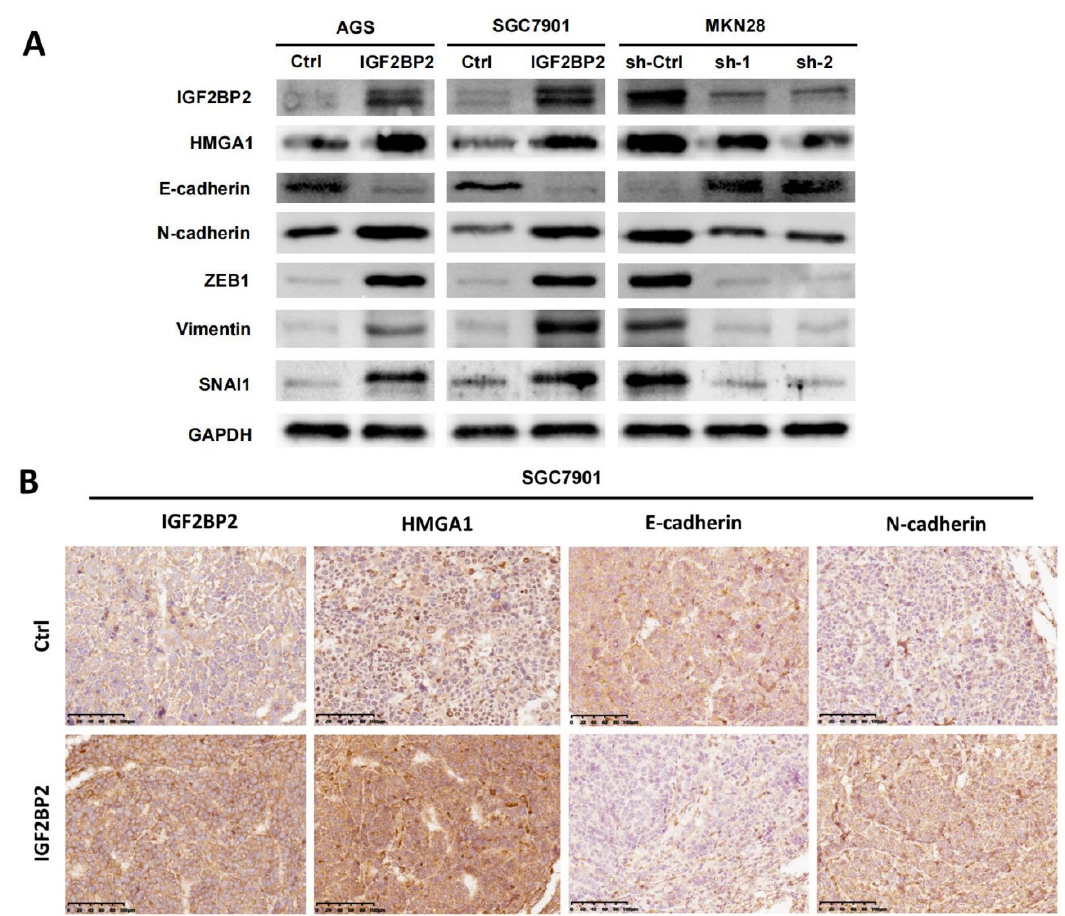
Figure 5. IGF2BP2/HMGA1 axis promotes EMT of GC. ( A ) The amounts of HMGA1, E-cadherin, N-cadherin, ZEB1, Vimentin, and SNAI1 and in AGS, SGC7901, and MKN28 cells in which IGF2BP2 was overexpressed or knocked down were evaluated by Western blotting analyses. ( B ) Immunohistochemical staining was completed to evaluate the amounts of HMGA1, E-cadherin, and N-cadherin in metastatic lung lesions removed from mice injected with IGF2BP2-overexpressing or control SGC7901 cells. Molecular weights for proteins are shown in the uncropped Western blot images (Figure S10).